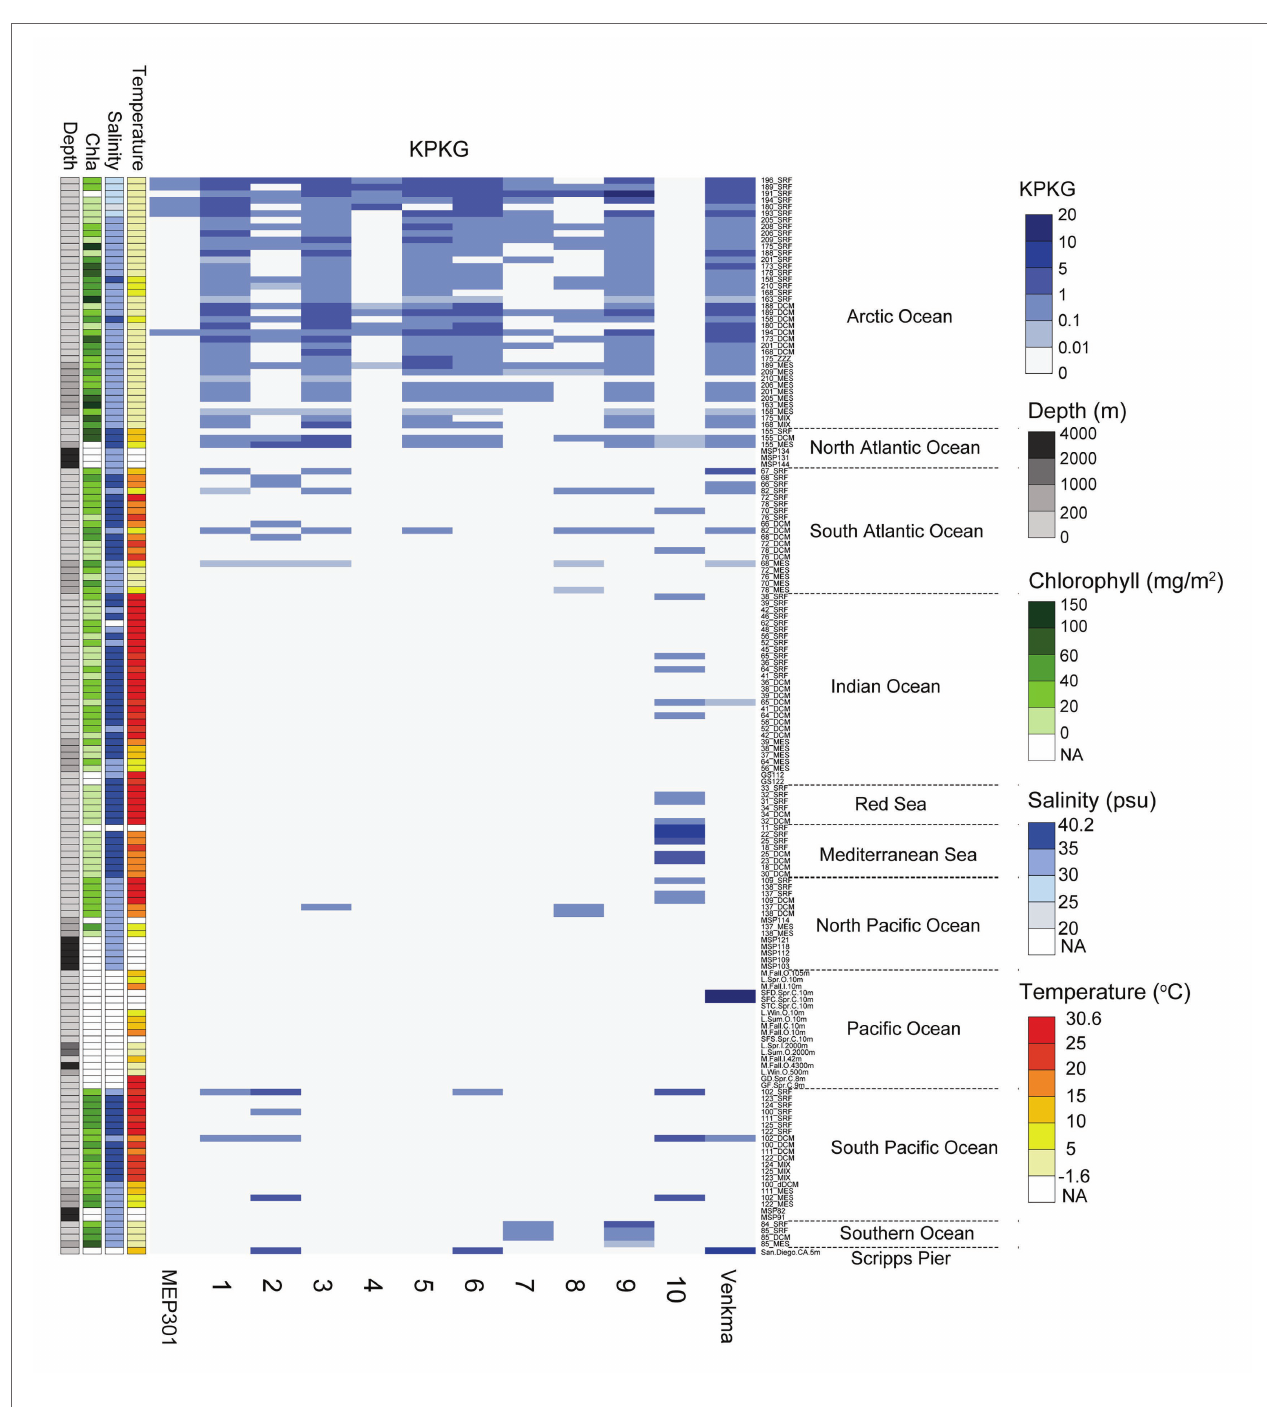
FIGURE 4 | Heatmap displaying the relative abundance of each MEP301-type phage in different marine viromic datasets. Normalized relative abundance is depicted as total mapped nucleotides (kb) per kb of genome per gigabase of metagenome (KPKG). The number (1–10) on the x-axis represent the MEP301-type phage: 1. KX158644.1Uncultured_bacterium_clone_VISS3_088, 2. Station102_SUR_ALL_assembly_NODE_387_length_33295_ cov_11.029693, 3. Station173_DCM_ALL_assembly_NODE_3468_length_26058_cov_29.993501, 4.